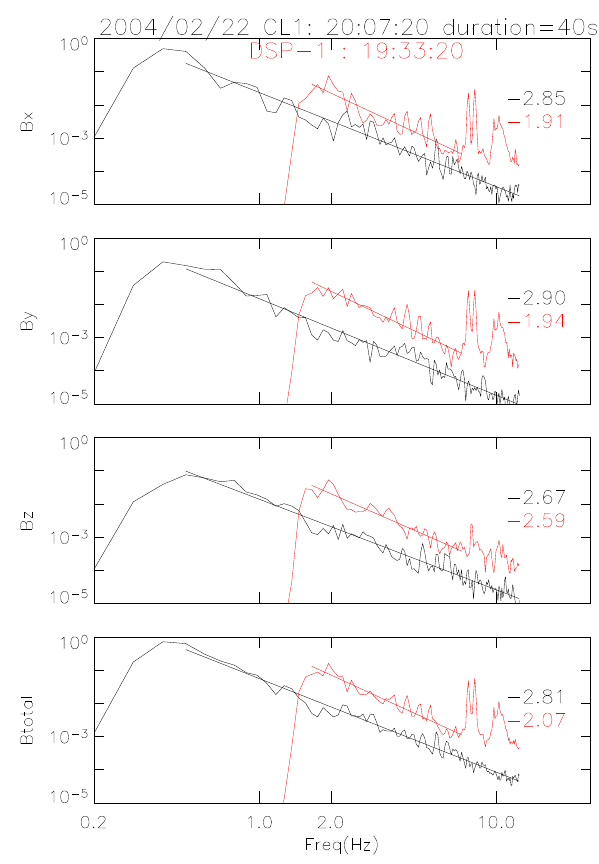
Fig. 11. Integrated power over 40s of ULF waves in the magne- tosheath, the closest possible to the magnetopause, for both DSP (in red) and Cluster (in black) for the 3 components in GSE. To avoid the interferences, DSP data are filtered below 2Hz. The power fit to a power law (nearly straight lines) is stopped at 6Hz, to avoid higher frequency interferences in the spin plane. Nevertheless, we will only consider the B z components. The exponents of the power law are shown at the right-hand side of each panel. The power law is similar for both spacecraft, but the power is stronger for DSP, at low latitude, than observed by Cluster which crosses the magnetopause at 62deg of latitiude (see Table